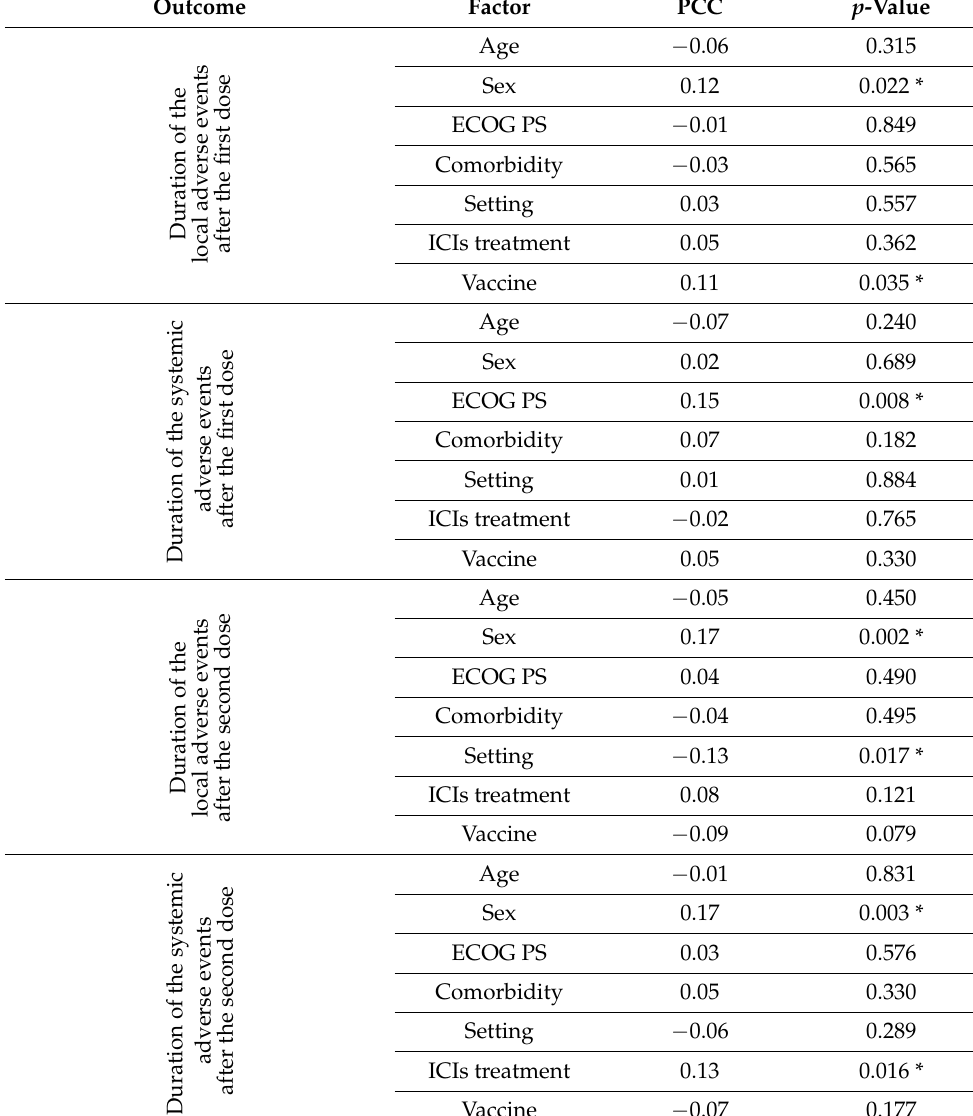
Table 5. Multiple linear regression of the clinical factors influencing the continuous outcomes based on the adverse events duration. Age: (0) <65, (1) ≥ 65; Sex: (0) M, (1) F; ECOG PS: (0) 0, (1) 1, (2) ≥ 2; Comorbidity: (0) no, (1) ≤ 2, (2) ≥ 3; Setting: (0) adjuvant and neoadjuvant, (1) metastatic; ICIs treatment: (0) no, (1) yes; Vaccine: (0) with mRNA, (1) with viral vector. PCC: partial correlation coefficient; *: p -values reaching statistical